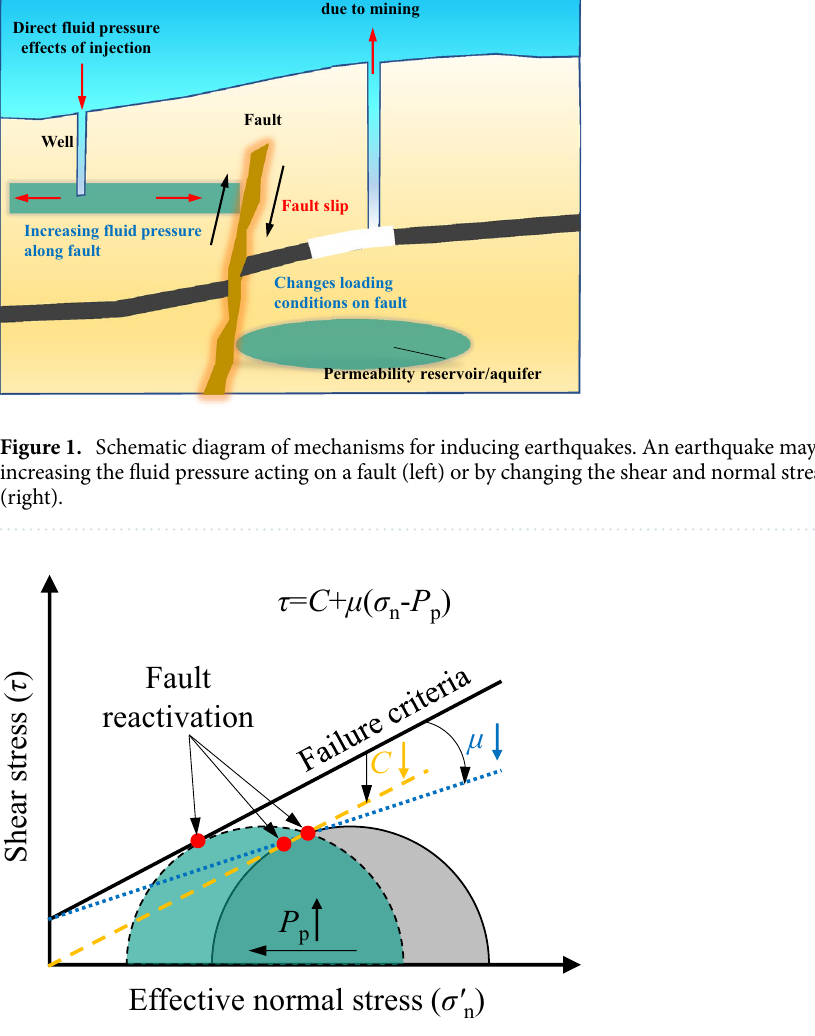
Figure 2. Mohr–Coulomb diagram for shear